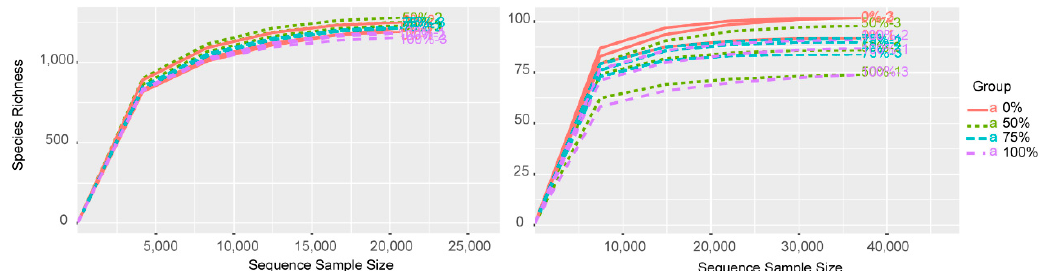
Figure A1. OTU rarefaction curve for bacterial and fungal communities with different amounts of straw added. Each group had three replicates ( n = 3). The left picture shows bacterial OTUs and the right picture shows fungal OTUs.